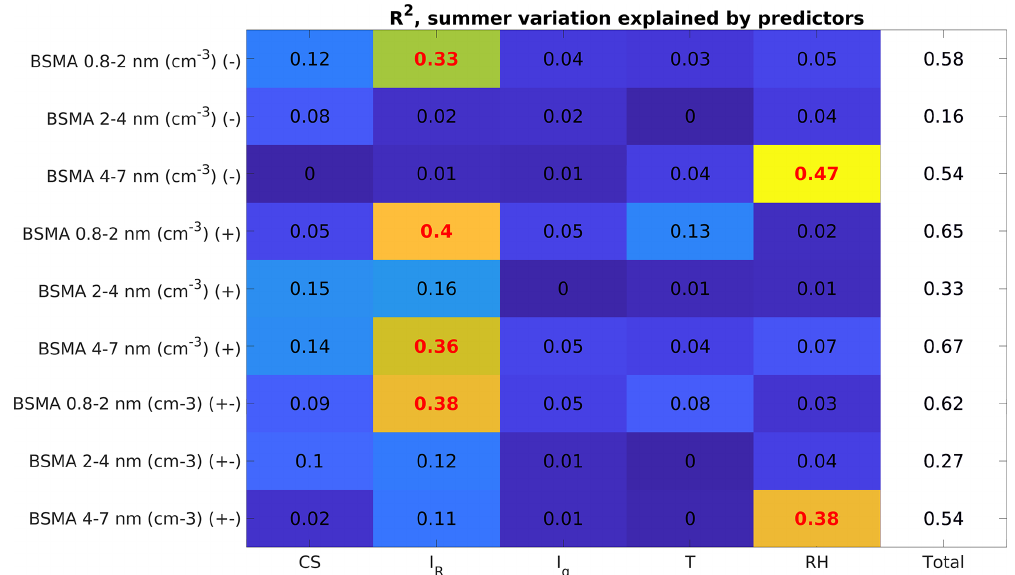
Figure A4. The amount of variation explained by our chosen explanatory variables for each size range and polarity. The data points selected are only between June and August and represent changes in summertime concentrations. The symbol ( − ) denotes negative polarity, ( + ) a positive polarity, and ( ± ) the sum of both polarities. The bolded red values are statistically significant ( p < 0 .